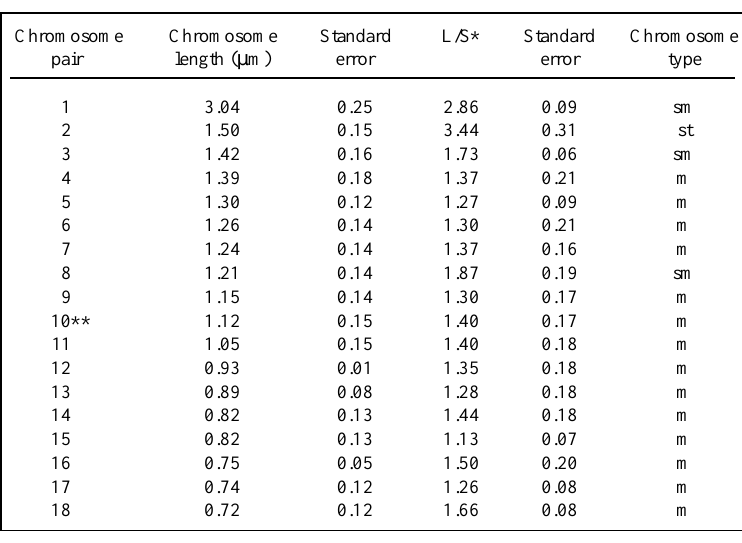
Table I - Mean chromosome length ( m m) and arm ratio of five metaphases of Mikania cordifolia , and chromosome type.